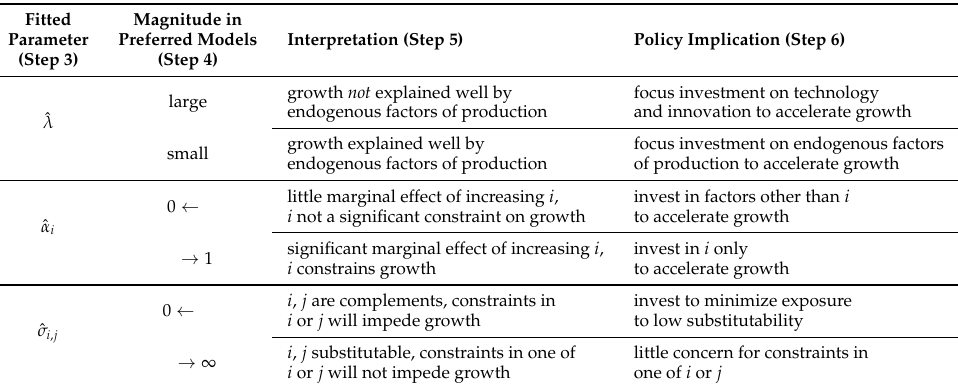
Table 4. Policy implications arising from fitted CES